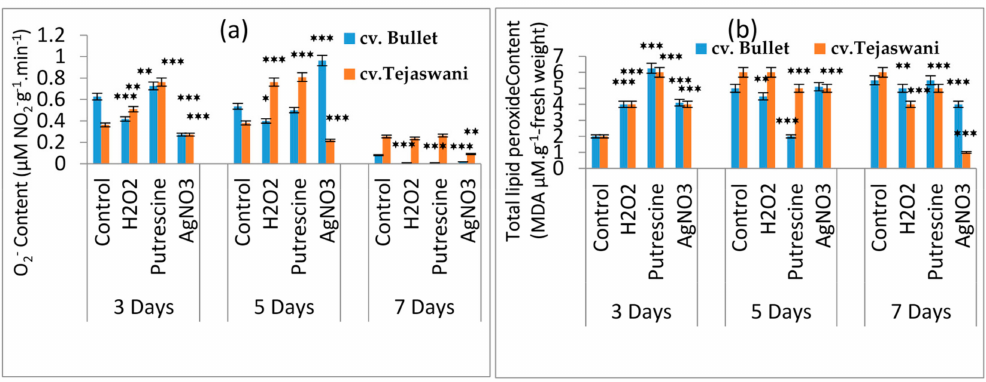
Figure 4. Changes of total O 2– content ( a )and total lipid peroxide content ( b ) of two chili types, i.e., cv. Bullet and cv . Tejaswani, under di ff erent treatments (control, H 2 O 2 , putrescine, and AgNO 3 ) and durations (3, 5, and 7 days). The vertical bars represent the data with means of three replicates with ± SE ( n = 3) from the individual set of experiments, and significant di ff erences between treatments as calculated by student’s t-test marked as *( p ≤ 0.05) ** ( p ≤ 0.01) *** ( p ≤